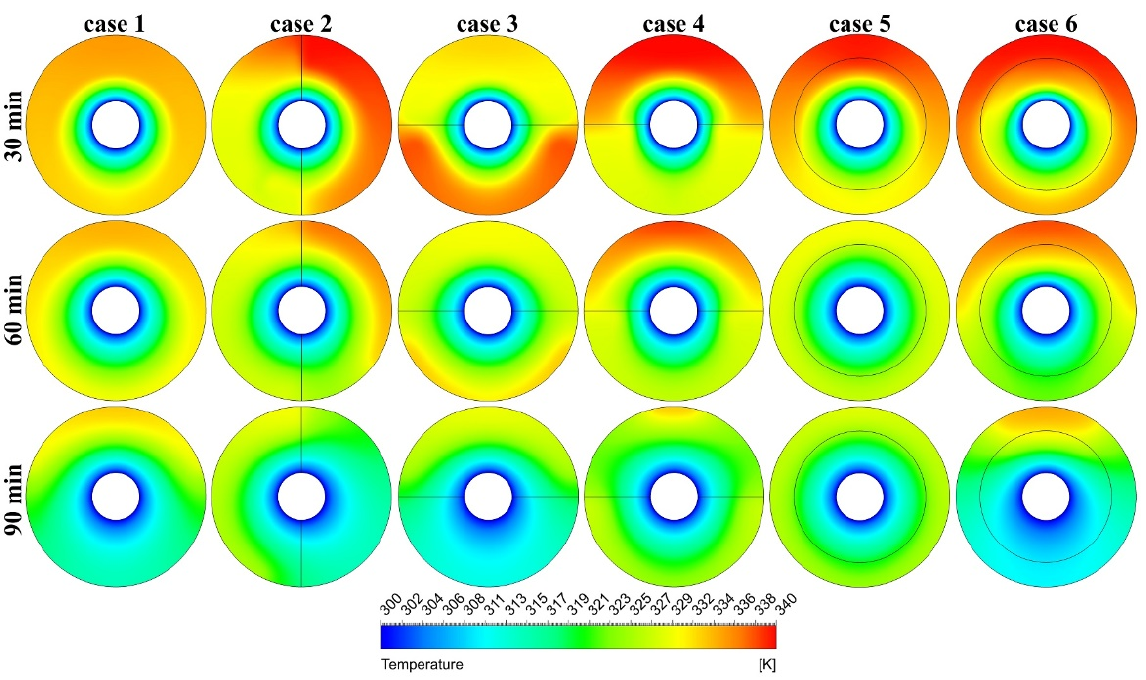
Figure 6. Temperature contours of the studied cases at different time-stages. At the time-stage of 90 min, the liquid fractions of 0.65, 0.079, 0.108, 0.0437, 0.114, and 0.0421 are reported for cases 1–6, respectively. Case-4 and case-6 reveal better solidification responses according to the liquid-fraction evolutions (refer to Figure 5). PCM-3